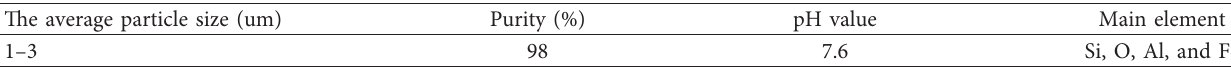
Table 3: Some properties of